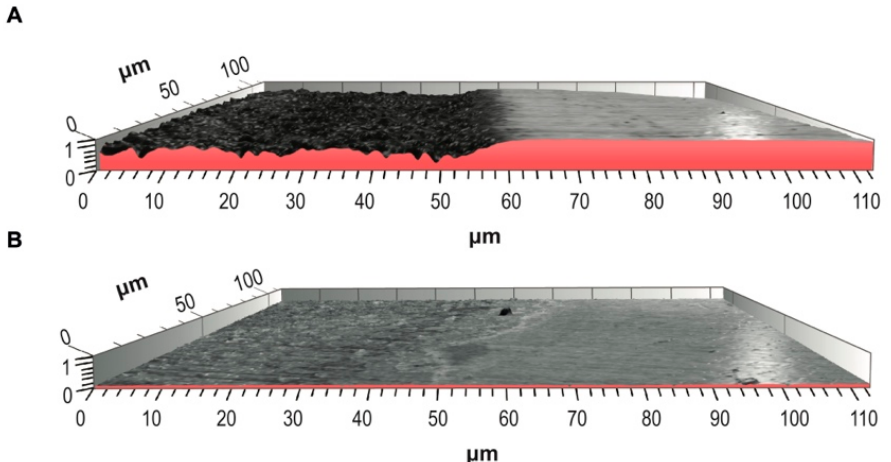
Figure 2. Three-Dimensional surface images of the discontinuity between the measured surfaces; ( A ) a comparison between NE (right) vs. EE (left). Note the material loss represented by a step between the surfaces. ( B ) the NE (right) vs. FEE (left). Here the difference between the surfaces is much less pronounced due to the protective effect of